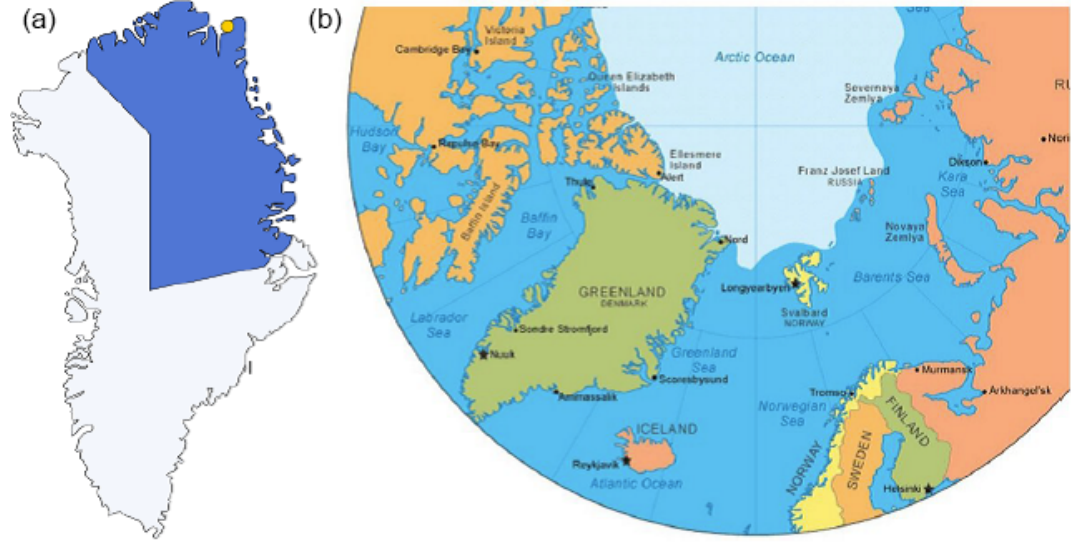
Figure 1. (a) Greenland with indication of the largest natural reserve in the world (blue) and the position of Station Nord (yellow dot). (b) The Northern Hemisphere where Station Nord (Nord) also can be